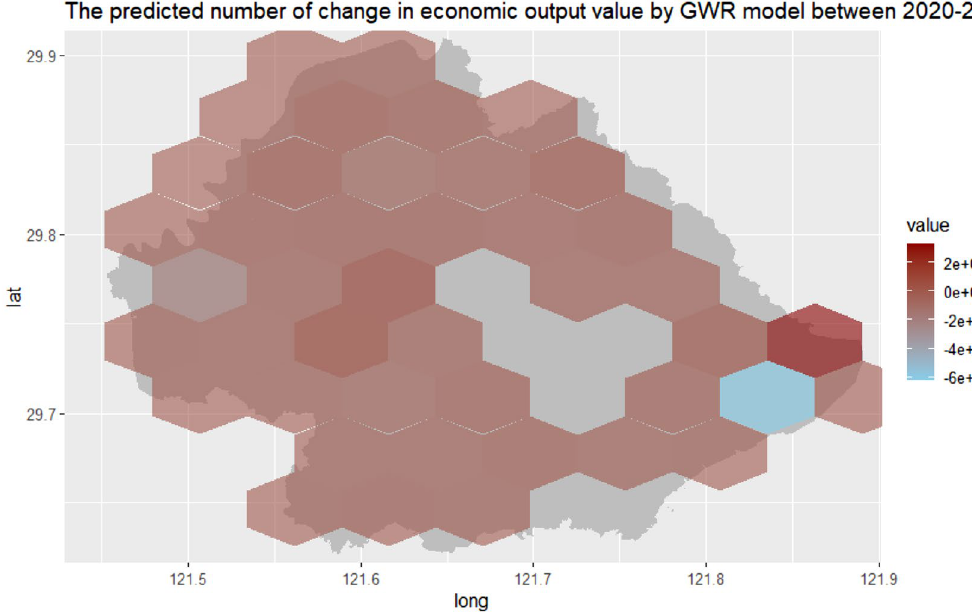
Figure 6. The spatial distribution of the predicted yearly change in economic output value based on the percentage of yearly positive online news by GWR model in Yinzhou, 2020–2021.